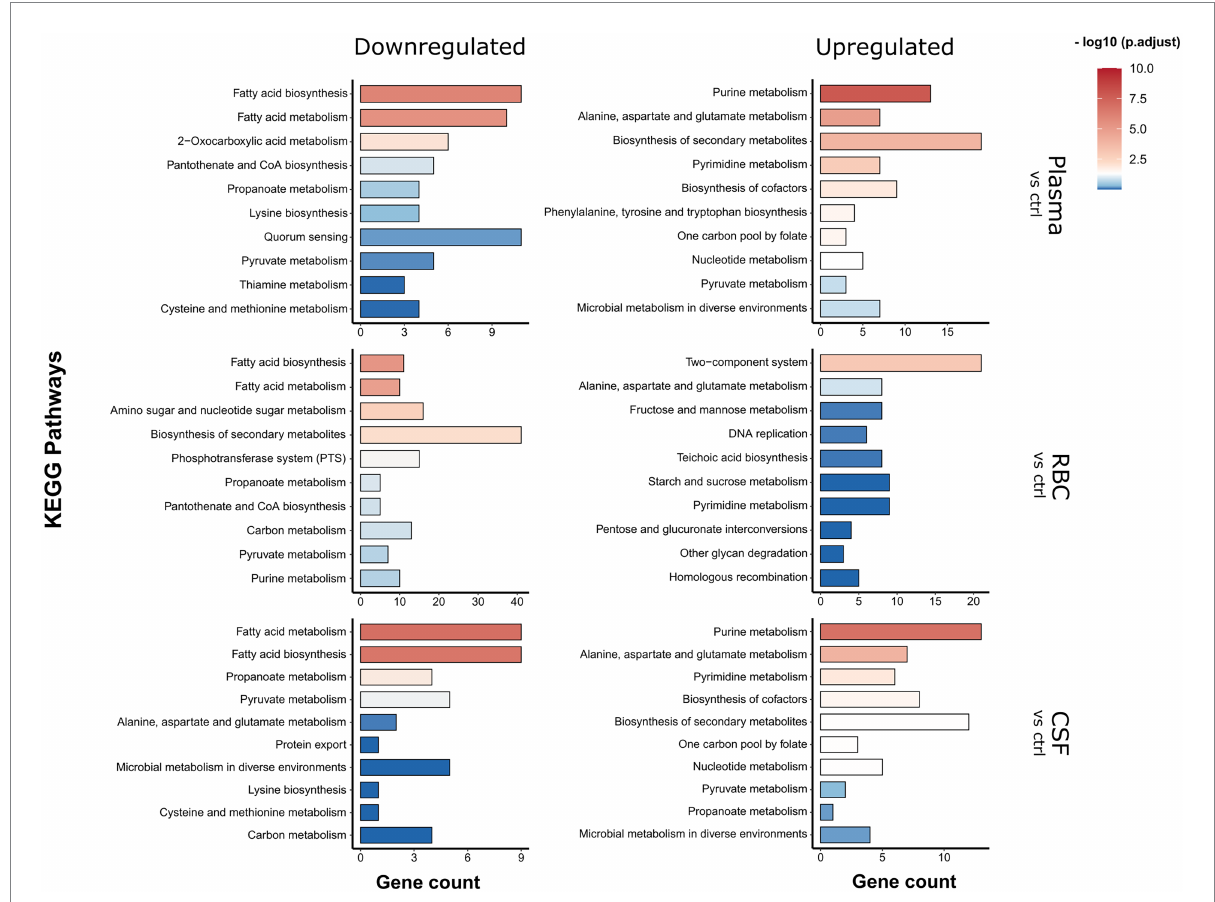
FIGURE 3 KEGG pathway enrichment analysis. Analysis was carried out on significantly differentially expressed genes [log 2 (FC) > 1 fold and FDR < 0.01]. KEGG pathways significantly enriched in the pool of up-or downregulated genes compared to the full genome background are represented by a red color hue, and non-significantly enriched pathways are represented by a blue color